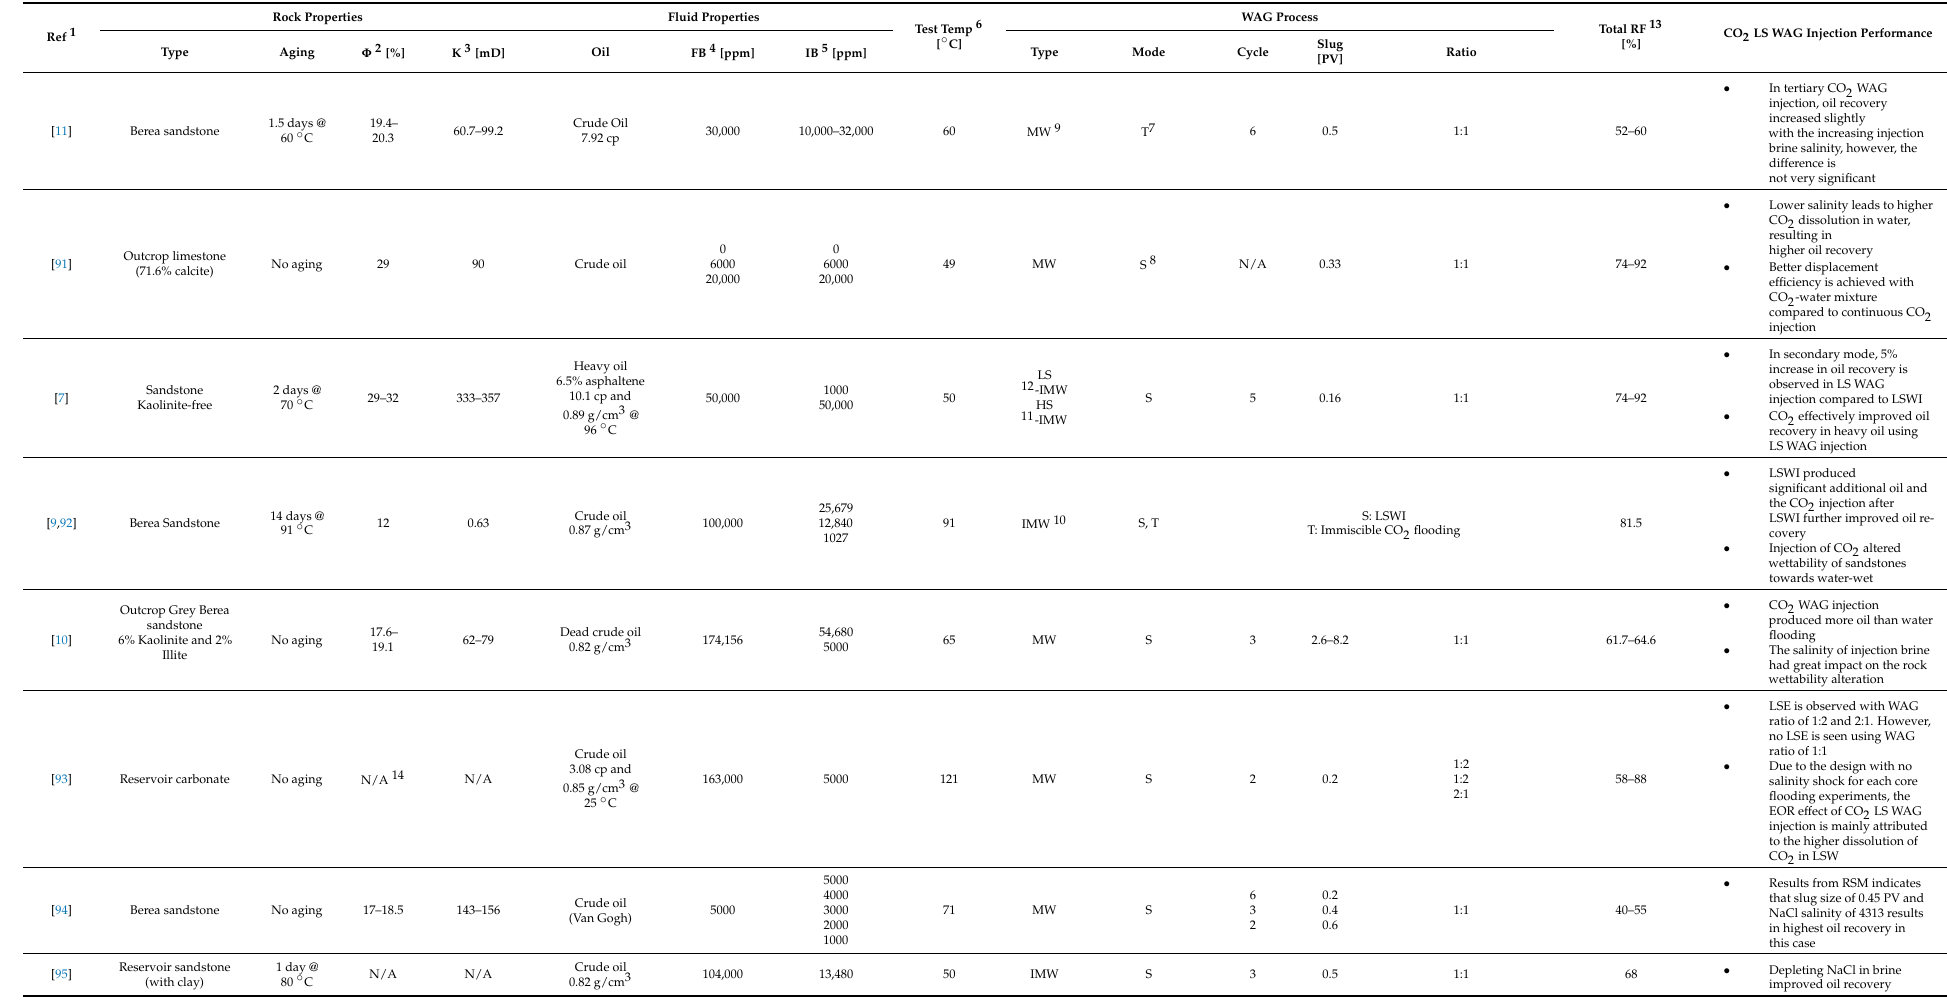
Table 1. Summary of CO 2 Low Salinity WAG Injection Laboratory